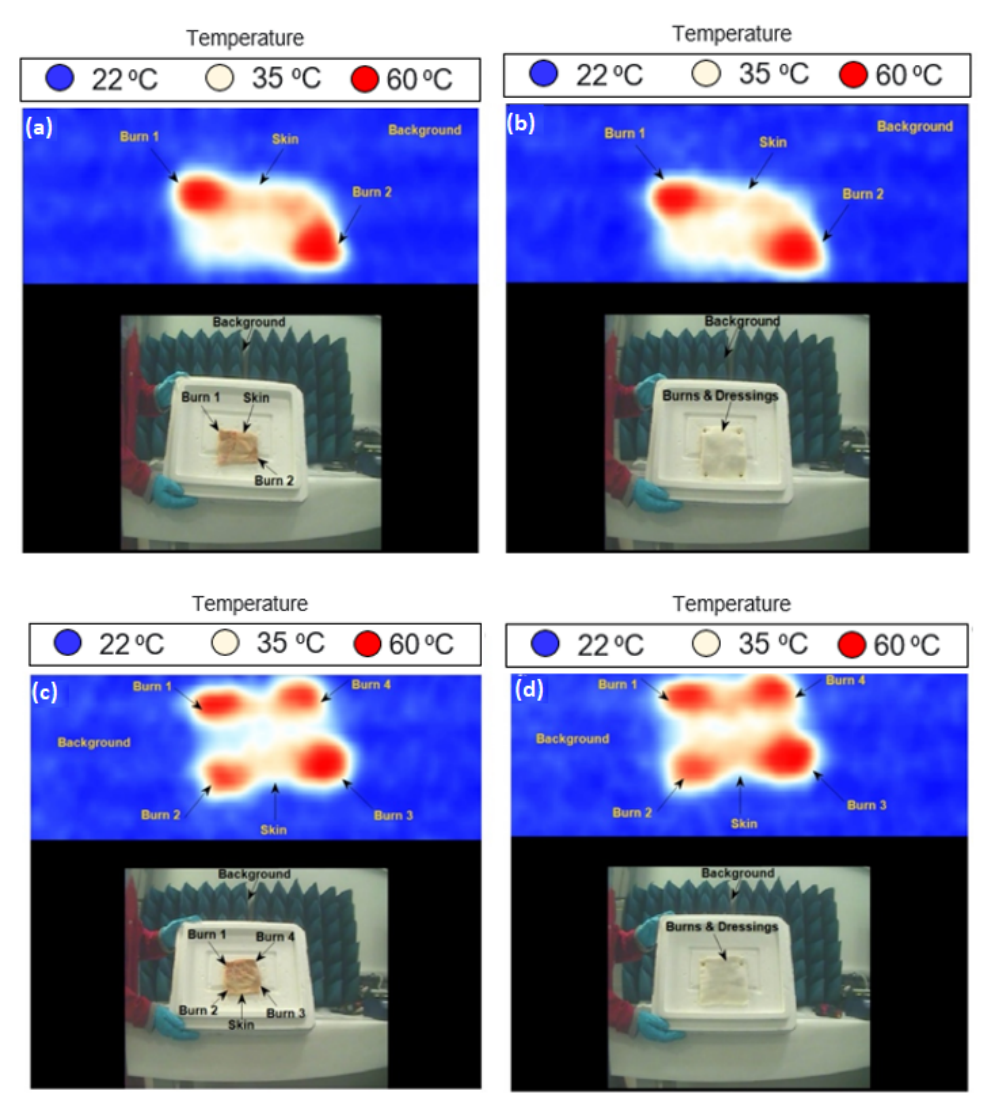
Figure 9. MMW images for porcine skin samples at 250 GHz; images in ( a , c ) represent the skin with burns and without dressing materials, whereas images in ( b , d ) represent the skin with burns and 10-layer gauze burn dressing materials. Each image has 229 (w) × 277 (h) pixels, and it takes 5 s to take a screenshot of an image.